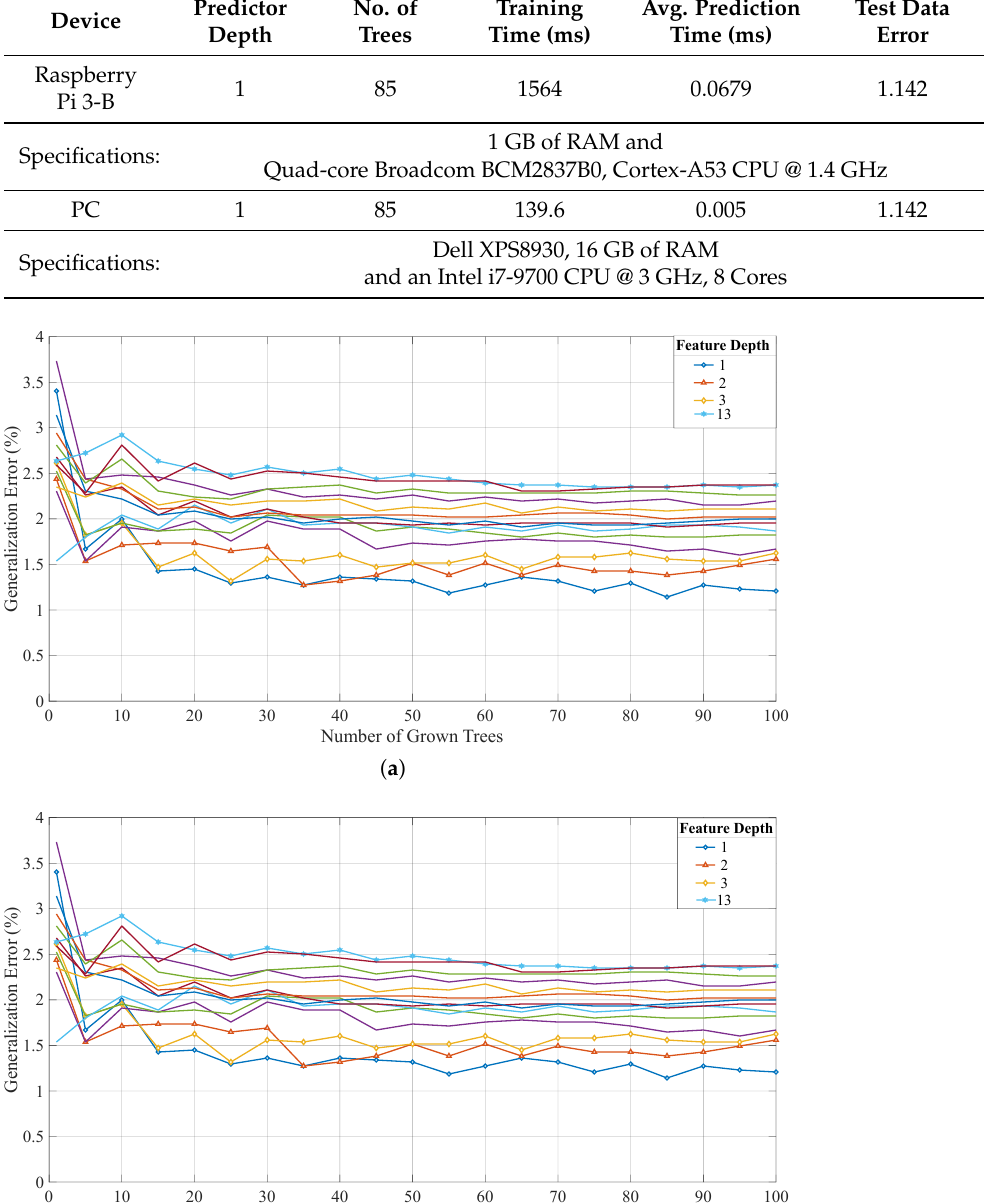
Table 6. Random Forest Classification Results: Device Comparison for Wireless Data.